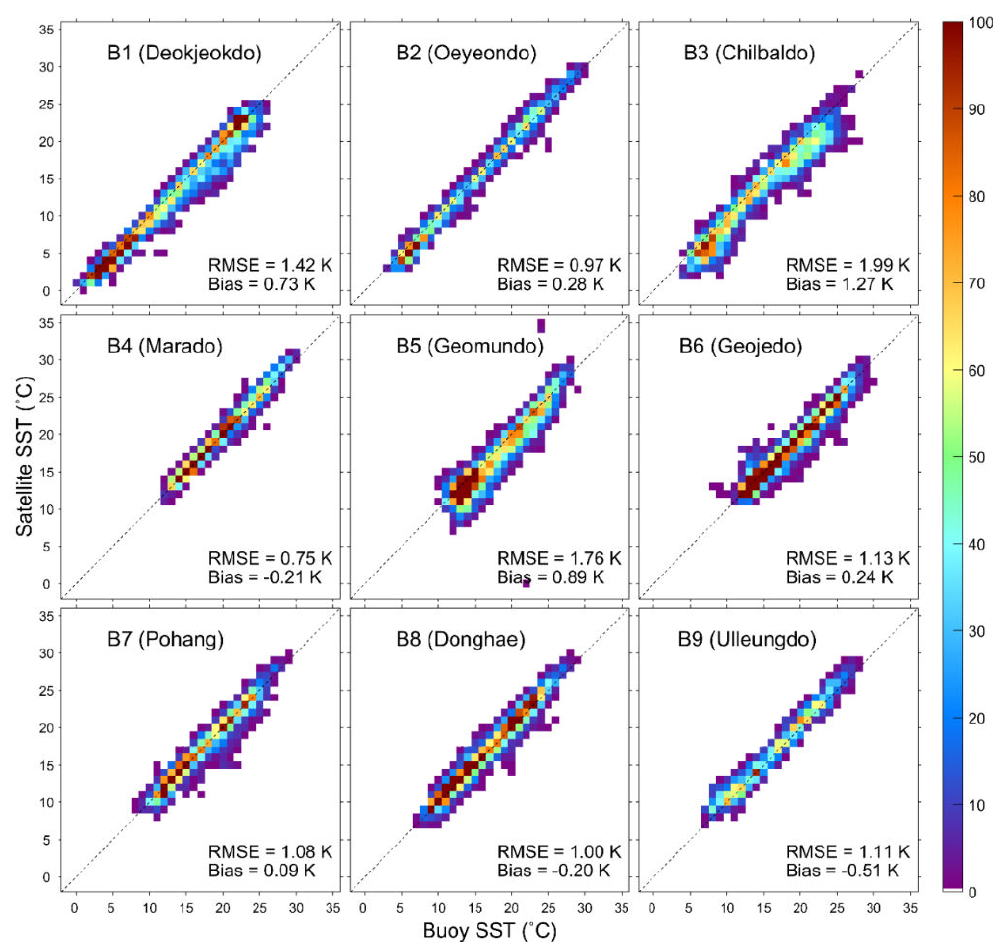
Figure 2. Comparison between satellite sea surface temperature (SST) and in situ SST at each buoy station of KMA, where the color represents the number density of the matchups.